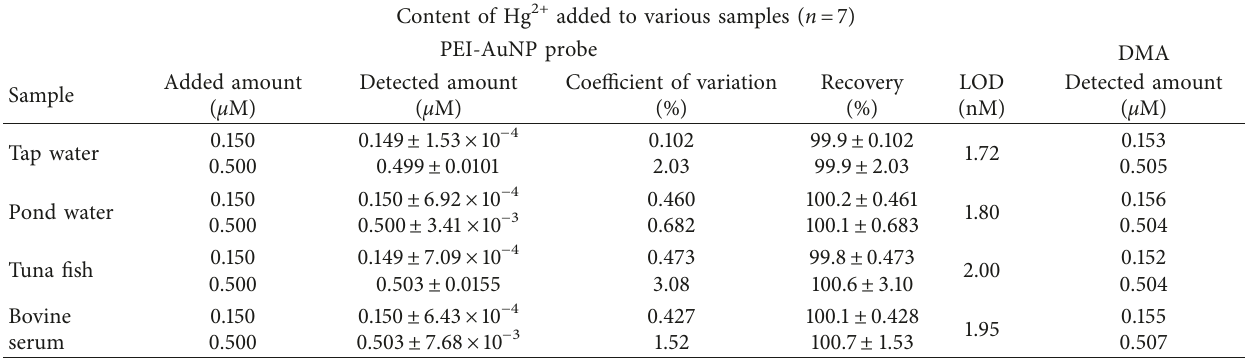
Table 1: Concentrations of Hg 2+ ions measured by the PEI-AuNP colorimetric probe and DMA in tap water, pond water, tuna fish, and bovine serum samples spiked with Hg 2+ ions.